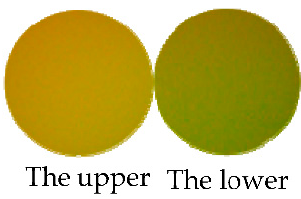
Figure 14. Experimental picture of Slide 2. Table 5. Experimental data of the thickness of Slide